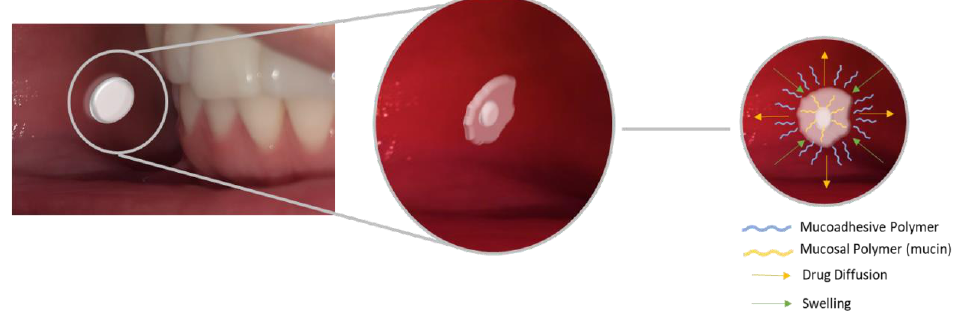
Figure 3. Factors that influence the behavior of mucoadhesive tablets and their drug release profile.